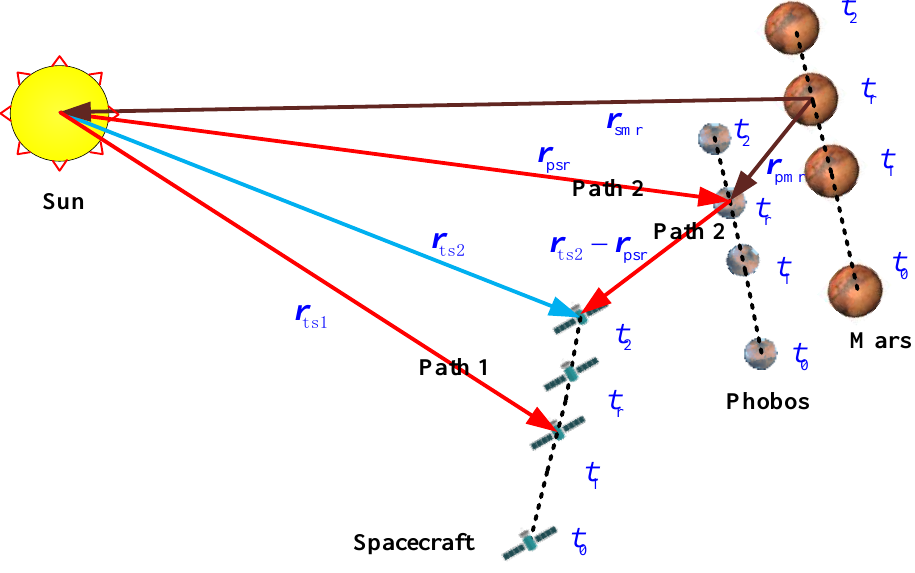
Figure 1. Measurement model of solar oscillation time delay.